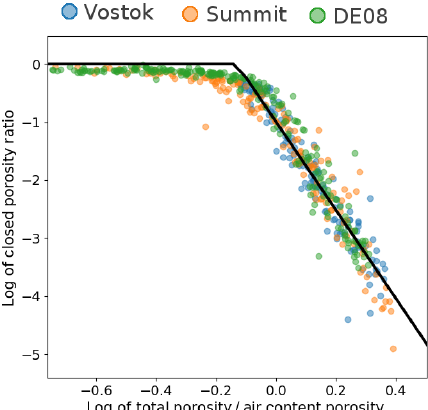
Figure 4. Relationship between the logarithm of the closed porosity ratio and the logarithm of the total porosity. The solid black line corresponds to the Barnola parameterization. The closed porosity data were obtained with the original processing